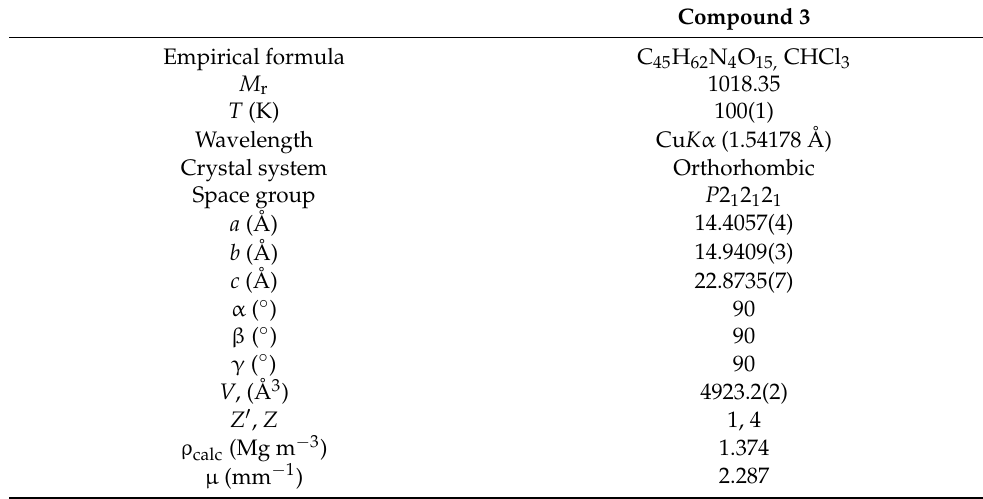
Table 1. Sample, data collection and structure refinement for compound 3